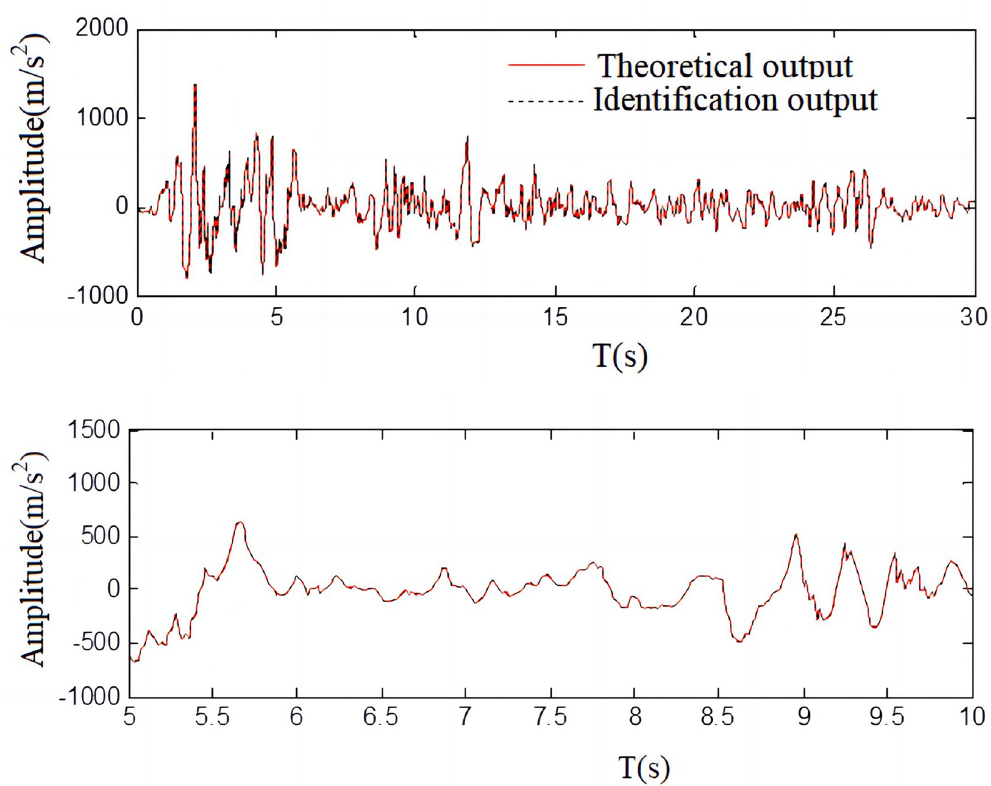
Fig 14. Acceleration time history curve. (a) Acceleration time history curve; (b) Local magnification of acceleration time- history curve.